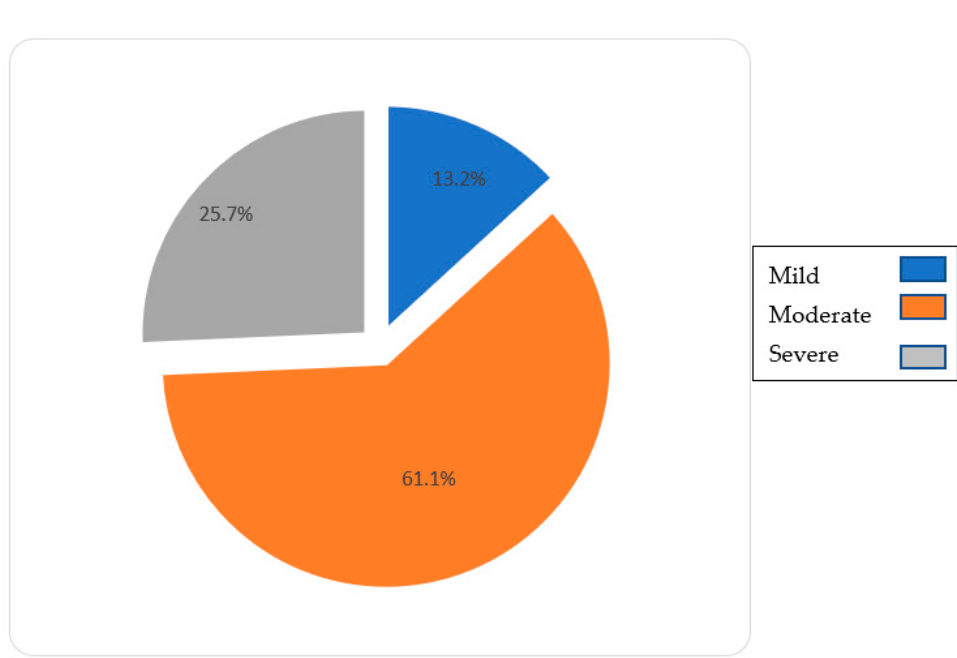
Figure 3. Dementia phase. Table 1. Demographic outcomes by severity stage.